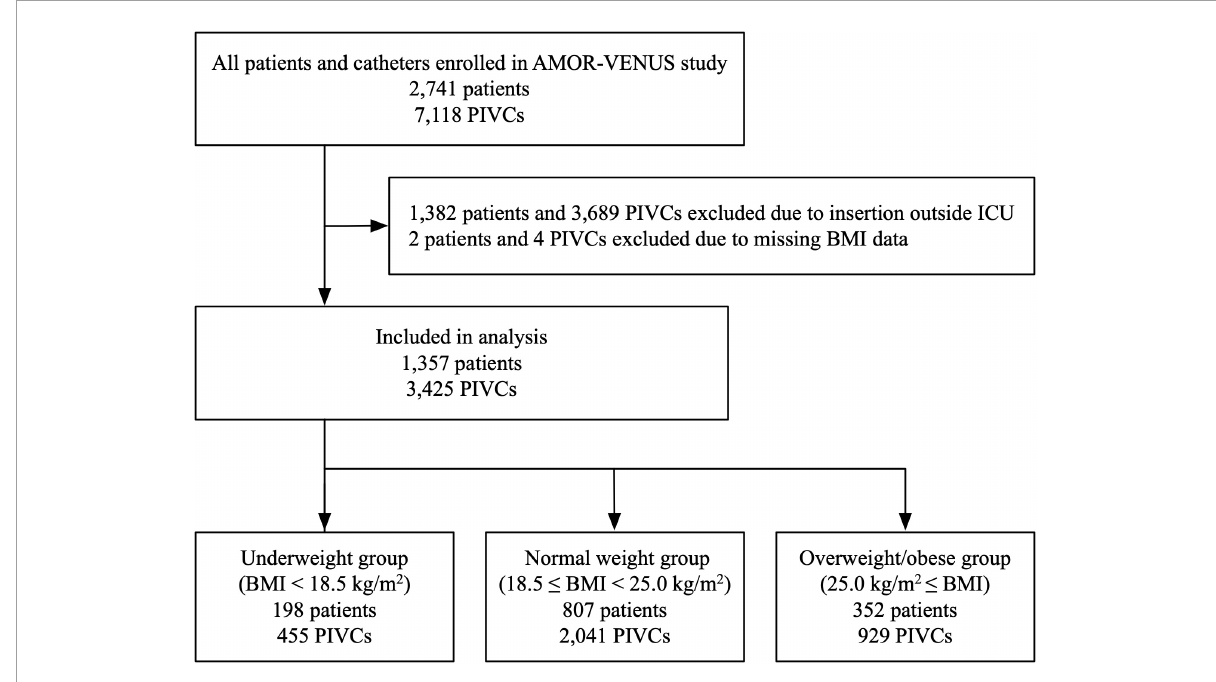
FIGURE1 Flowchart of study participants. BMI, body mass index; ICU, intensive care unit; PIVC, peripheral intravascular catheter.